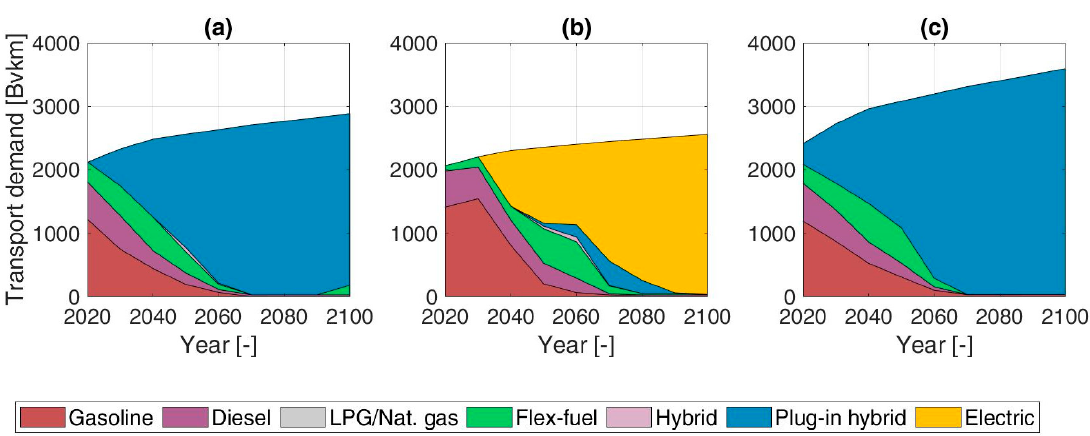
Figure 9. Heavy-duty vehicle (HDV) fleet composition in the three analyzed storylines: A ( a ), B ( b ) and C ( c) .